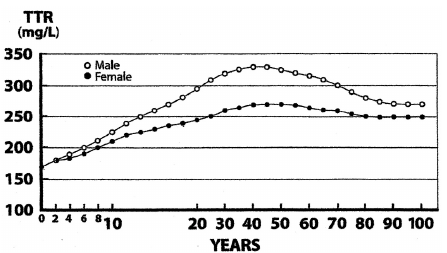
Figure 3. Evolutionary profiles of transthyretin (TTR) concentrations throughout the human lifespan. Evolutionary profiles of TTR concentrations measured in the blood samples from 67,720 healthy U.S. citizens using immunoturbidimetric analysis (Bienvenu et al., [40]). TTR and LBM values manifest progression without sexual difference until the onset of puberty, occurrence of sexual dimorphism with more pronounced rise in adult males because of a larger musculature, followed by plateau levels until the age of 60 years, and finally gradual downsizing toward sarcopenia in both sexes, with a steeper slope observed in elderly males. Both TTR and LBM curves show comparable abrupt S-shape elevations from the onset of adolescence until the beginning of adulthood, which are partially obliterated due to changes in the graduation of the abscissa